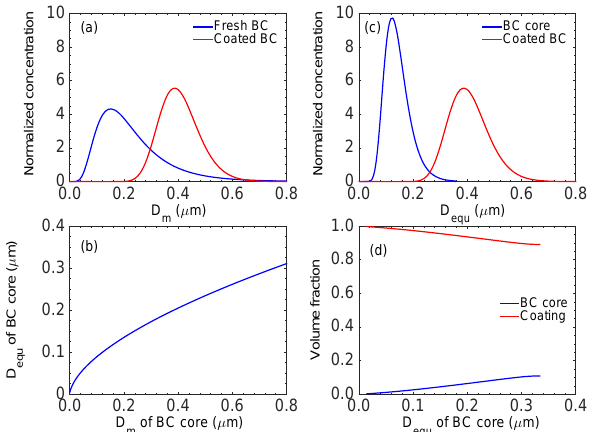
Figure 2. (a) Normalized particle number concentration of un- coated (i.e., fresh) and coated (after 24h coating) BC, assuming lognormal size distribution and utilizing a laboratory experiment by Schnaiter et al. (2005; see Fig. 5 of their study). (b) Estimated rela- tionship between the diameter of equivalent volume sphere ( D equ ) and mobility diameter ( D m ) for fresh BC aggregates. (c) The size distributions for the diameters of the equivalent volume spheres ( D equ ) of BC core and coated BC after 24h coating, based on pan- els (a) and (b) . (d) Estimated volume fractions of BC core and coat- ing material as a function of D equ of BC core, based on panel (c) .